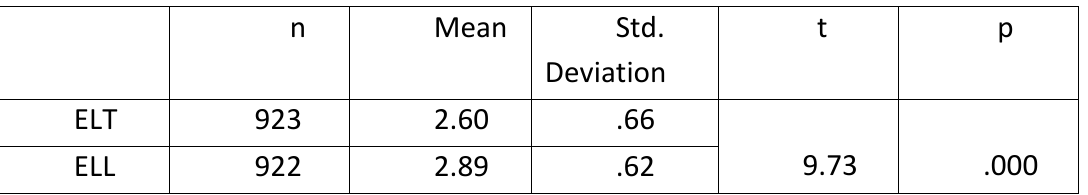
Table 3. Foreign Language Speaking Anxiety T-test results of ELT-ELL groups